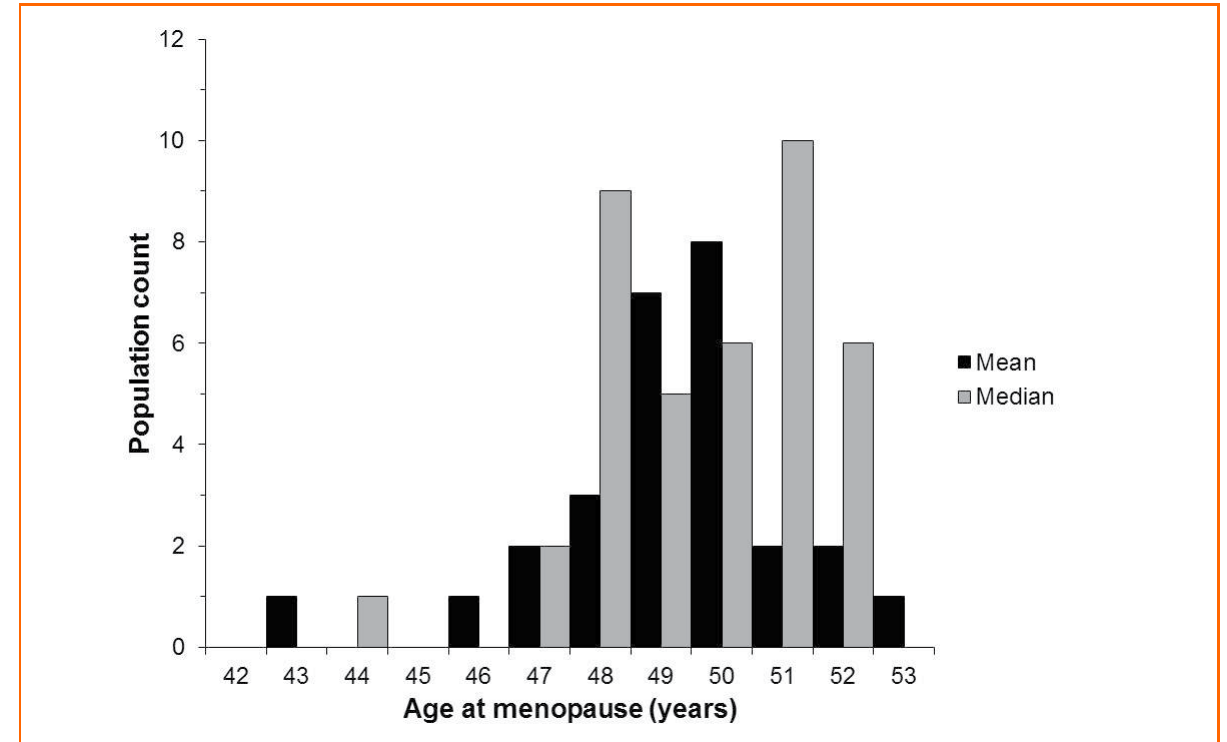
Figure 1: Number of populations (total N=53) with average (mean and median) ages at natural menopause within each age range (Adekunle et al. 2000; Ayatollahi et al. 2003; Beall 1983; Castelo-Branco et al. 2005; Chim et al. 2002; Garrido-Latorre et al. 1996; Gonzales et al. 1997; Ku et al. 2004; Mohammad et al. 2004; Balan 1995; Okonofua et al. 1990; Reynolds and Obermeyer 2003; Walker et al. 1984; Castelo-Branco et al. 2006; Burch and Gunz 1967; Chow et al. 1997; Fuchs and Paskarbeit 1976; Greer et al. 2003; Hunt, Jr. and Newcomer 1984; Ismael 1994; Kapoor and Kapoor 1986; Karim et al. 1985; Kato et al. 1998; Kriplani and Banerjee 2005; Kono et al. 1990; Kwawukume et al. 1993; Luoto et al. 1994; Magursky et al. 1975; McKinlay et al. 1985; Morabia et al. 1996; Ramoso-Jalbuena 1994; Reynolds and Obermeyer 2001; Rizk et al. 1998; Samil and Wishnuwardhani 1994; Tungphaisal et al. 1991; Walsh 1978; Carda et al. 1998; Hagstad 1988; Scragg